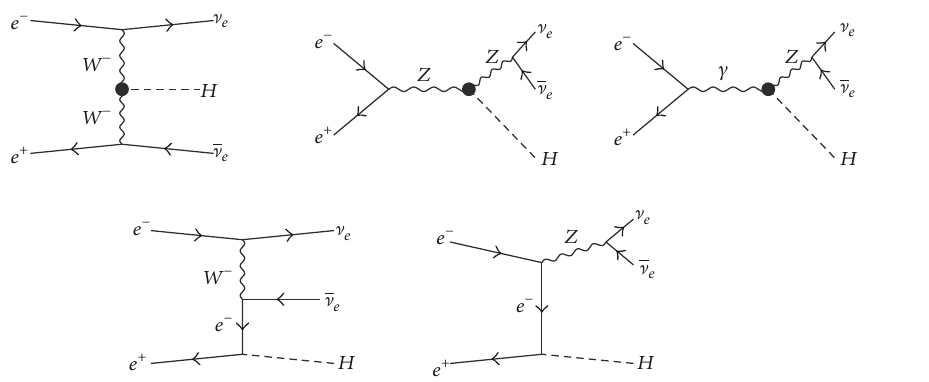
Figure 1: The Feynman diagrams for the process 𝑒 + 𝑒 − → ]] 𝐻 .